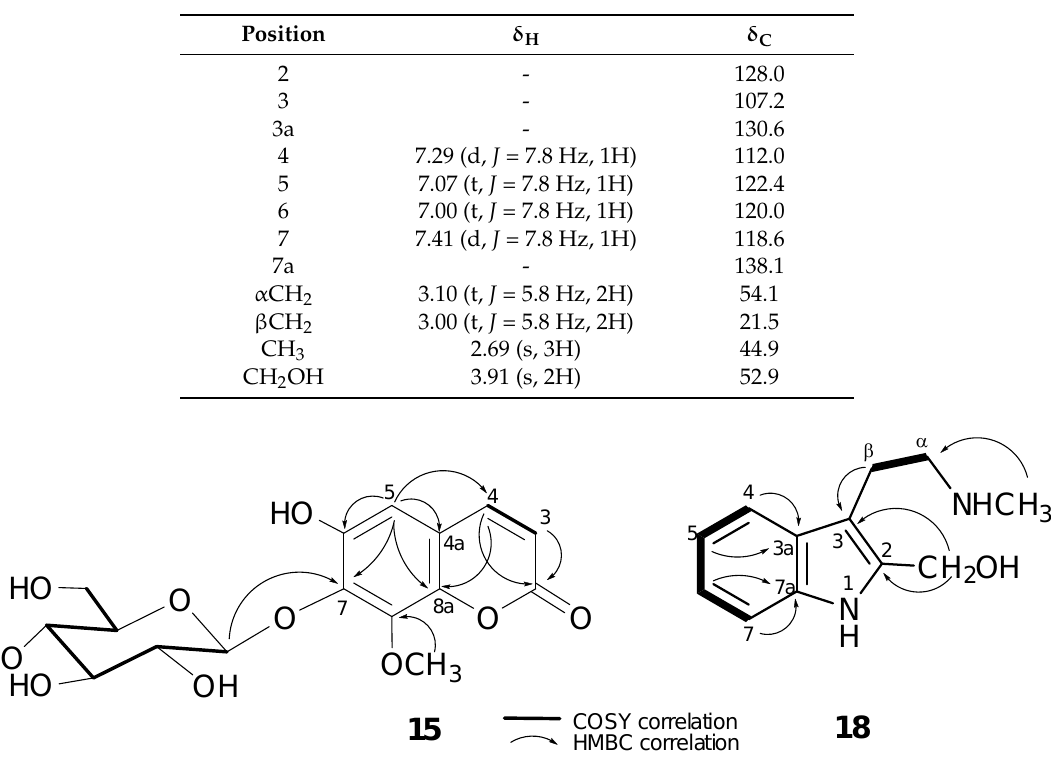
Table 2. The 1 H (700 MHz, δ in ppm, J in Hz) and 13 C NMR (125 MHz, δ in ppm) spectral data for compound 18 in deuterated methanol (CD 3 OD).